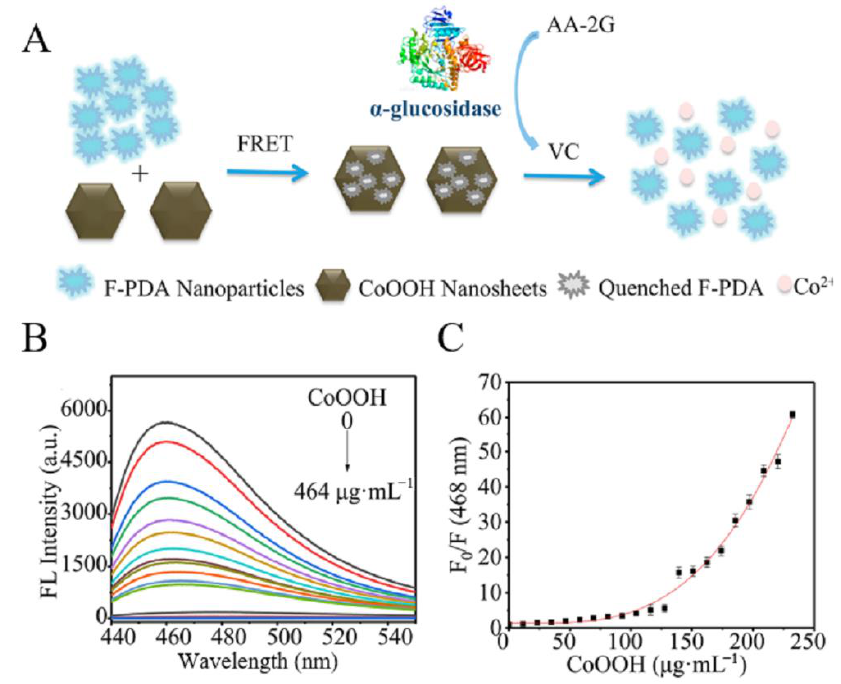
Figure 7. ( A ) Schematic of detection of α -glucosidase activity. ( B ) FL with different concentration of CoOOH. ( C ) Change in FL with CoOOH [113]. Reprinted/adapted with permission from Ref. [113]. 2019, Elsevier.